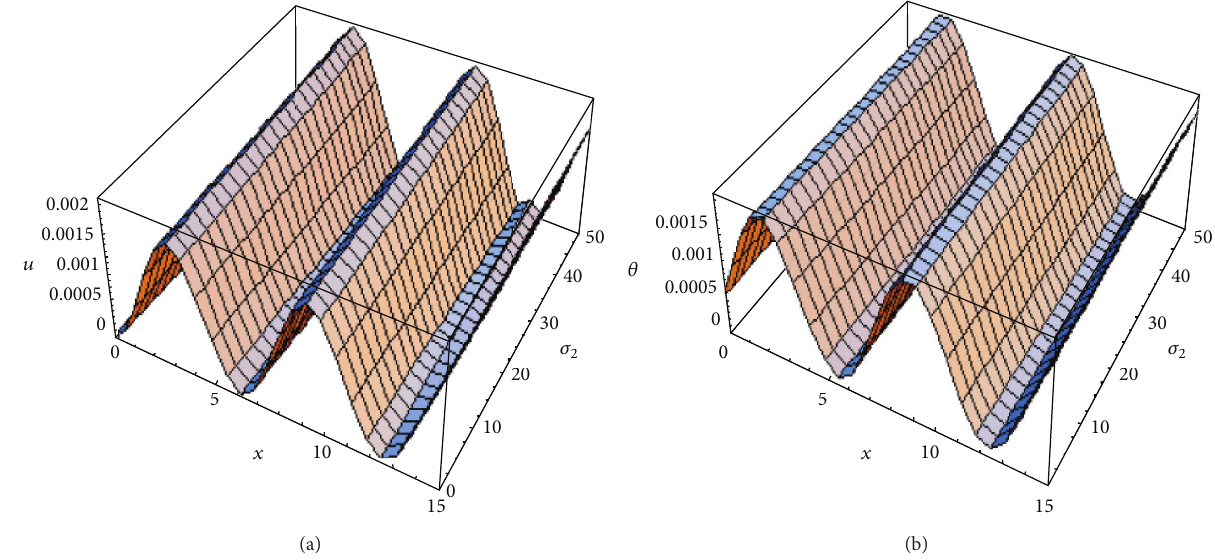
Figure 6: Variations of the displacement 𝑢 and temperature 𝜃 for various values of the 𝑥 -axis and magnetic field 𝜎 2 when 𝑡 = 0.1 , 𝜏 2 = 0 , = 0.1 , 𝛿 = 1 , and 𝜔 = 0.02 . 𝜏 1